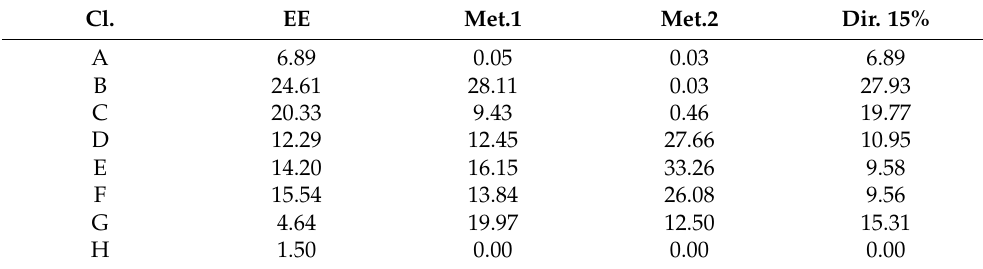
Table 8. EPC certificates (%) per energy class, as allocated by the different methods, for apartment buildings.